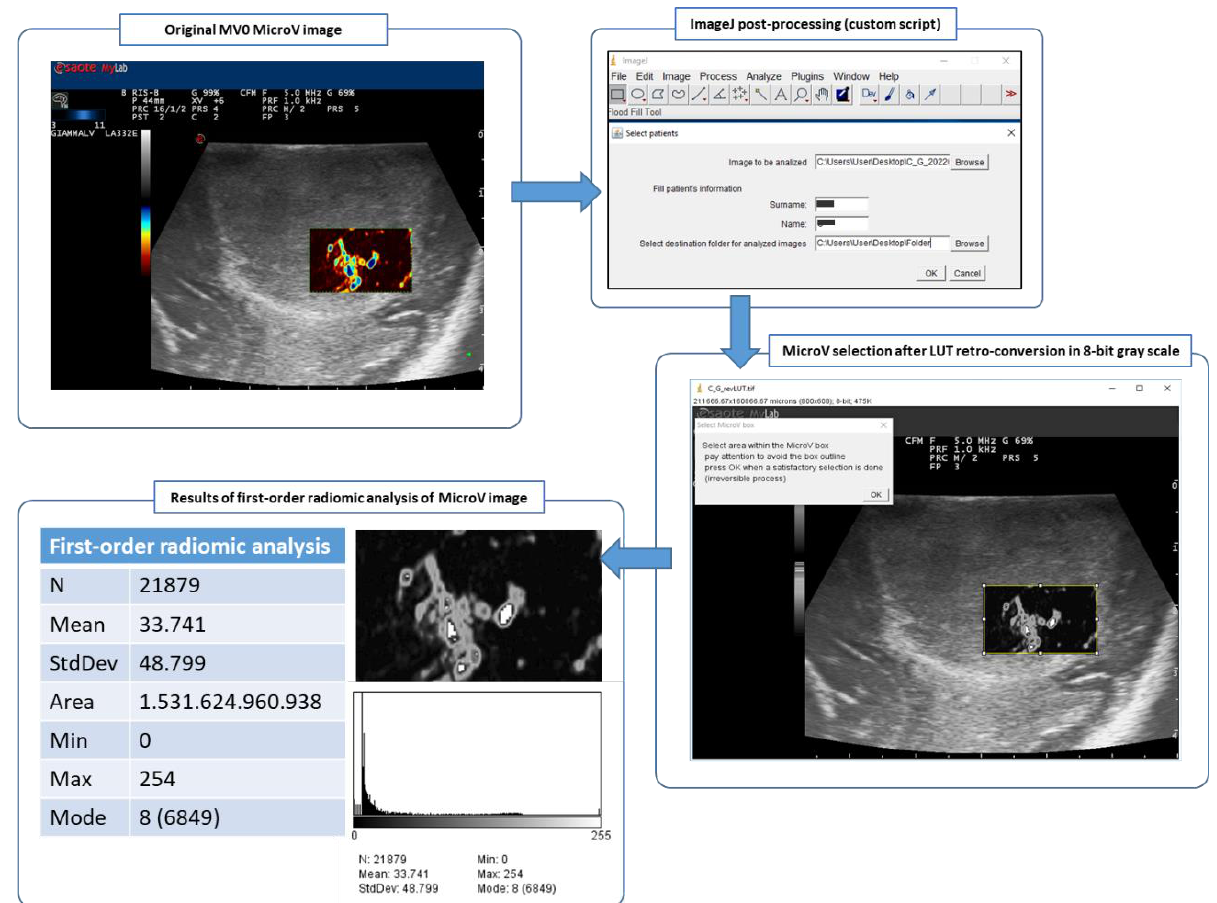
Figure 2. Post-processing ImageJ workflow of MicroV IOUS image with MV0 color map, from the original image to the 256 tones 8-bit grayscale image and finally to the first-order radiomic analysis of the selected area within the MicroV box.